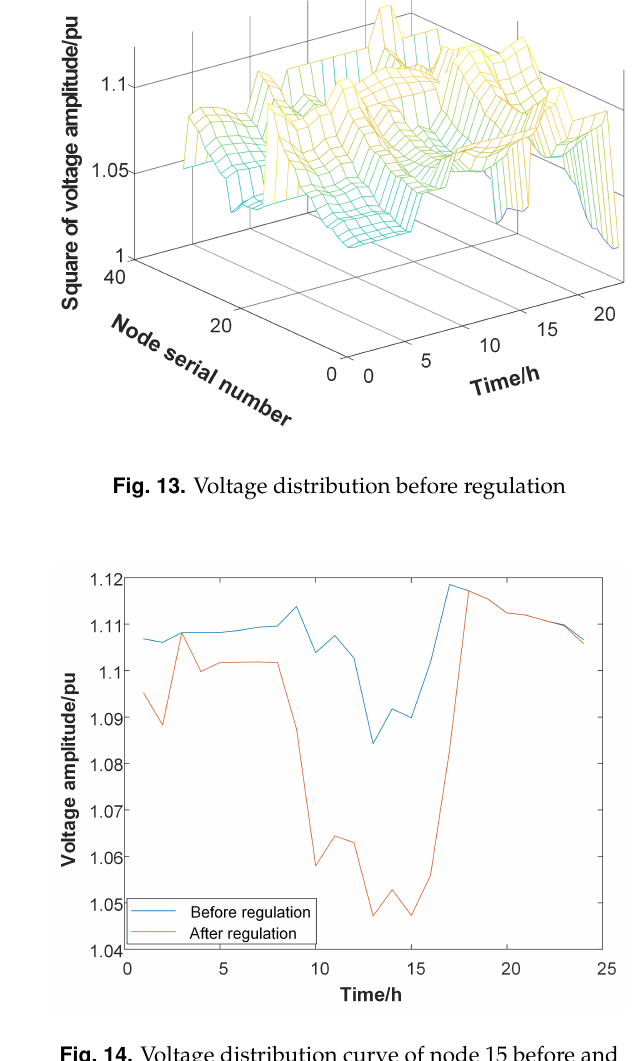
Fig. 14. Voltage distribution curve of node 15 before and after